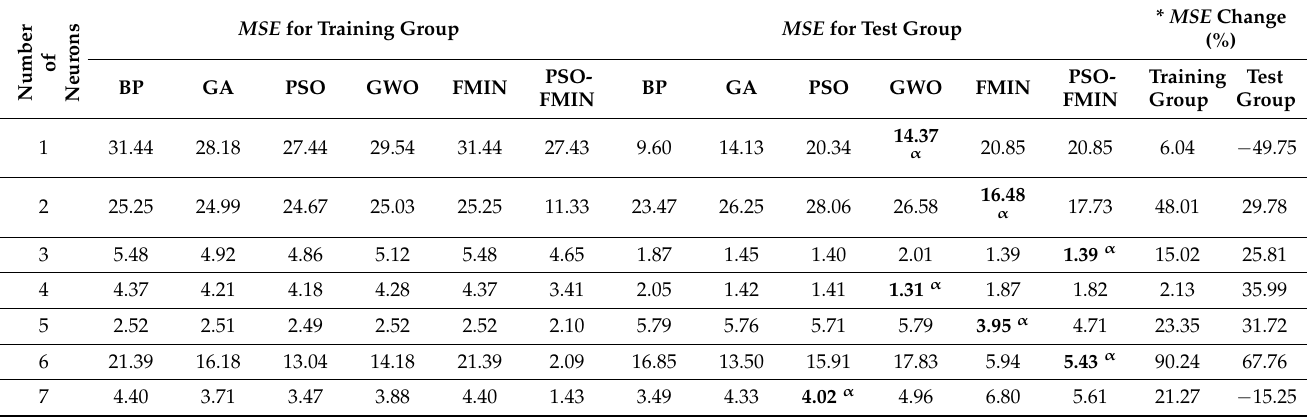
Table 6. Obtained results for the prediction of the b * color